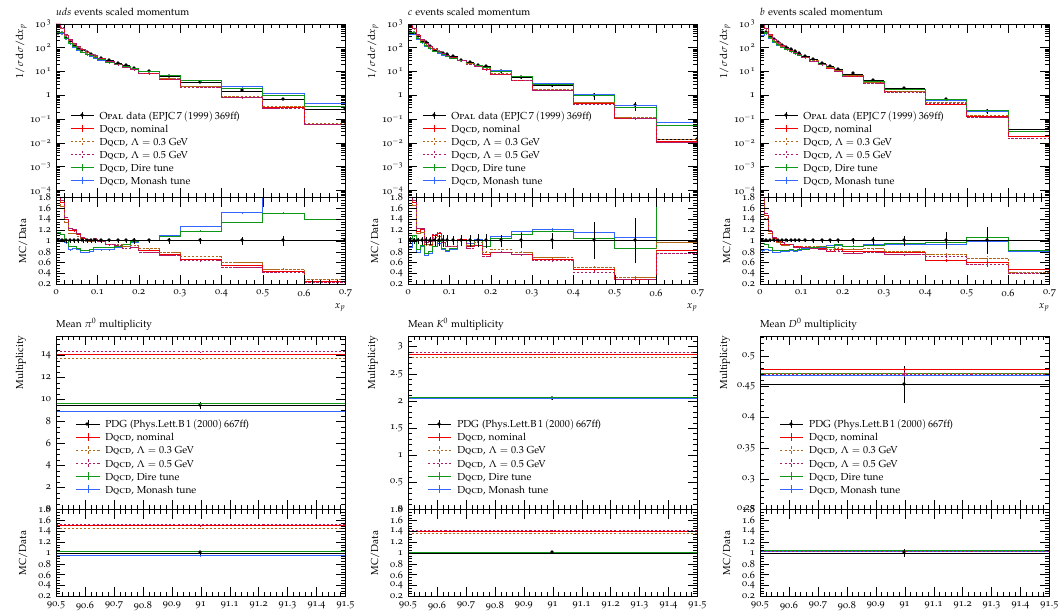
Figure 10. Comparative study for the affect of different tunes on the data agreement. Observables dominated by non-perturbative dynamics show mild-dependance on the mass scale Λ , but are sensitive to changes in the